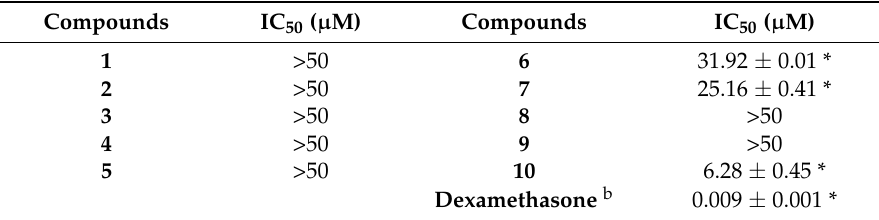
Table 1. Inhibition of NO production in RAW264.7 macrophages by alkaloids 1 – 10 a